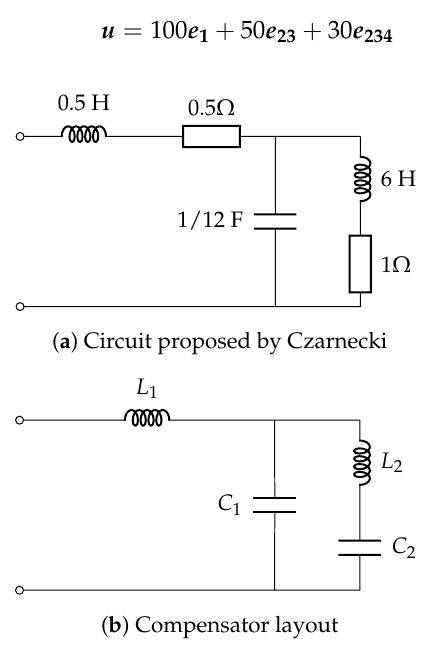
Figure 5. Load and compensator used by Czarnecki in